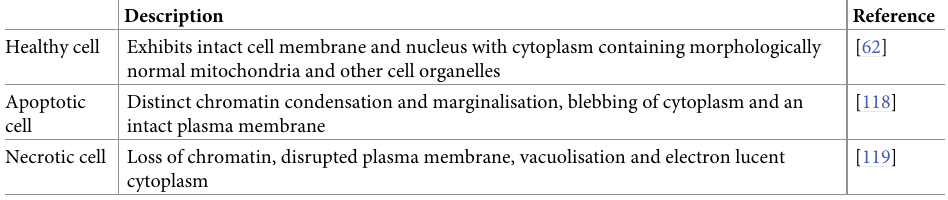
Table 4. TEM-based morphological characteristics of two major types of cell death: Apoptosis and